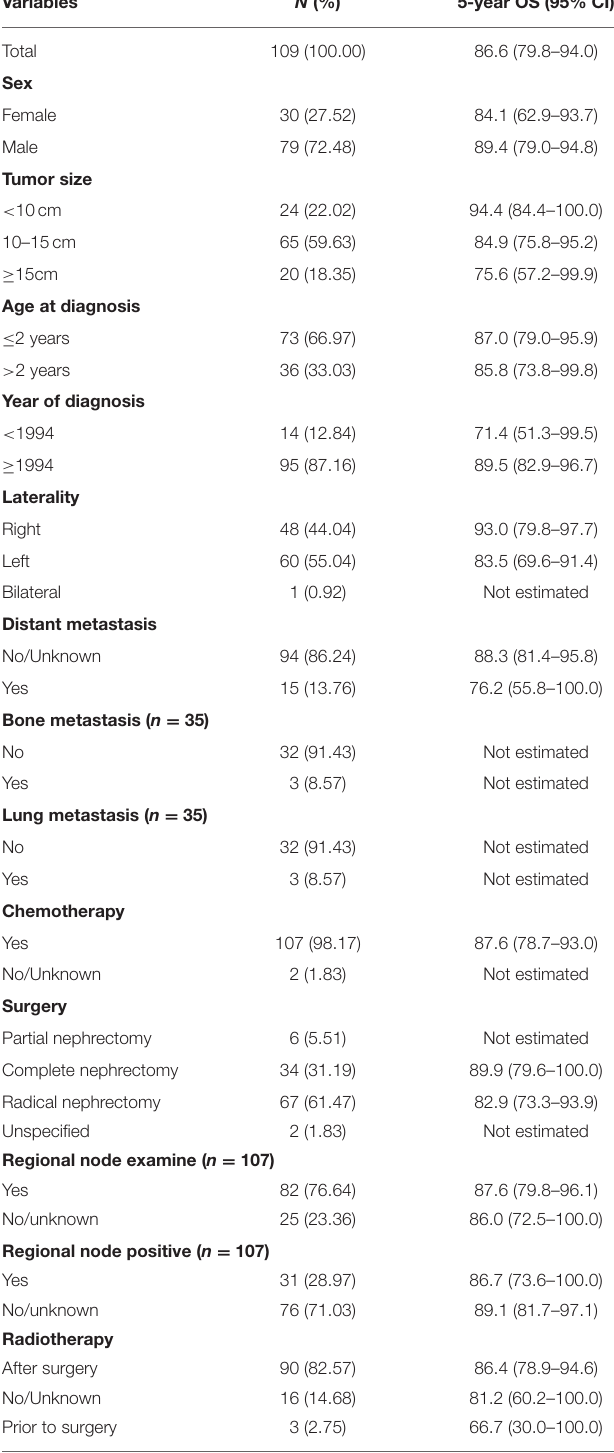
TABLE 2 | Multivariate analysis on potential prognostic factors for childhood CCSK. Variables